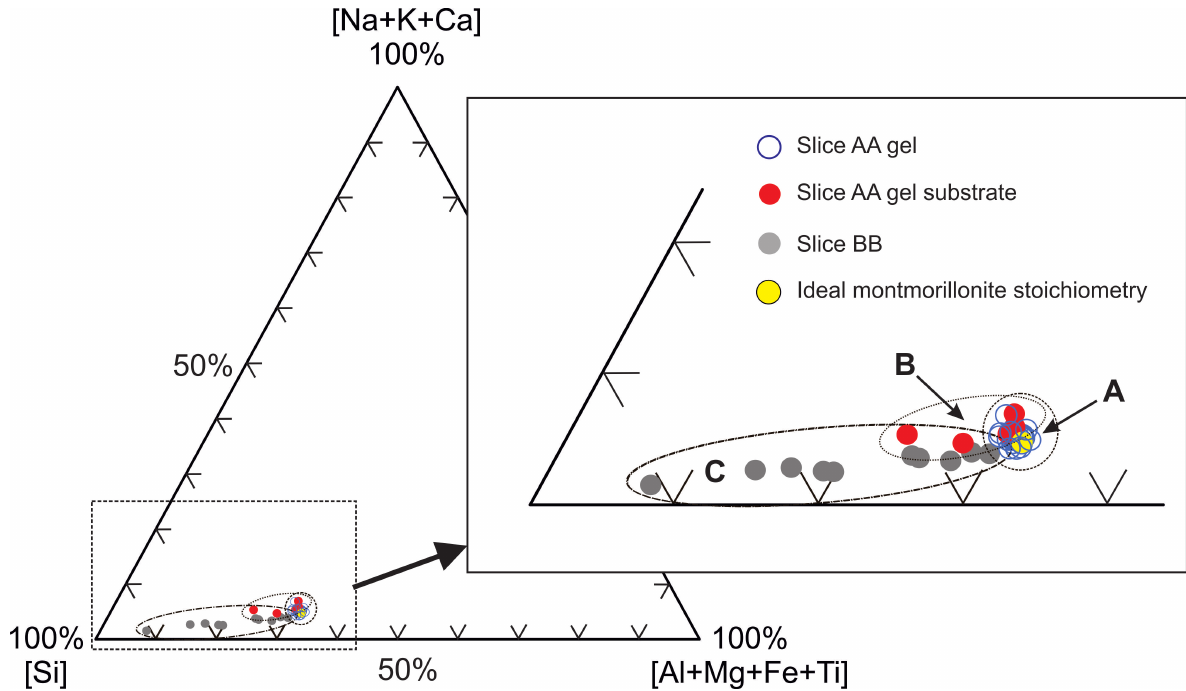
Figure 7. Molar ratio triplot of [Si] : [total Al, Fe, Mg, Ti] : [total N, K, Ca] from EDXA, illustrating the compositional variations between the hydrous gel (field A) and gel substrate (field B) from slice 1 piece AA, and background bentonite matrix (field C) from slice 2 piece BB. ’Ideal’ montmorillonite stoichiometry is shown for